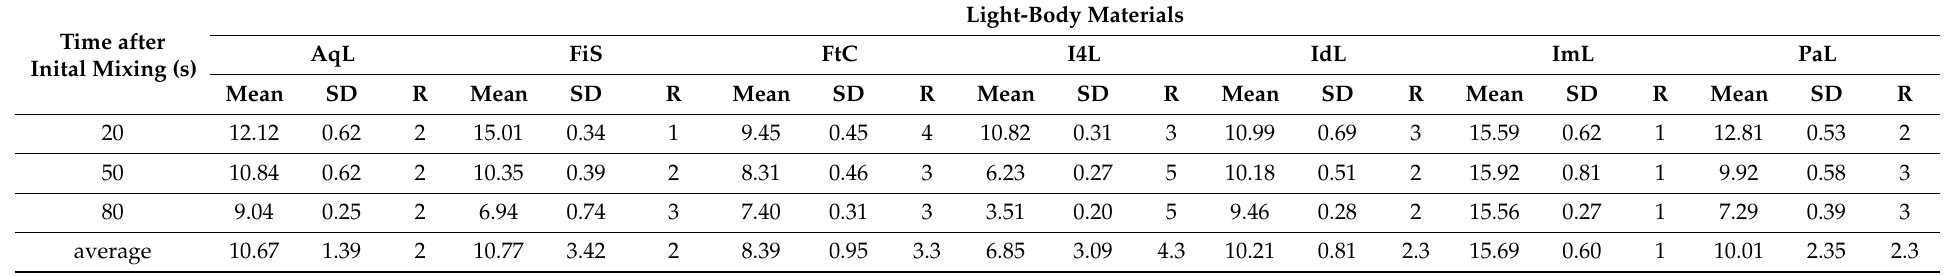
Table 2. Mean and SD of fin heights were derived after testing light-body materials and their ranks (R). Tests had a statistical difference within each time group.